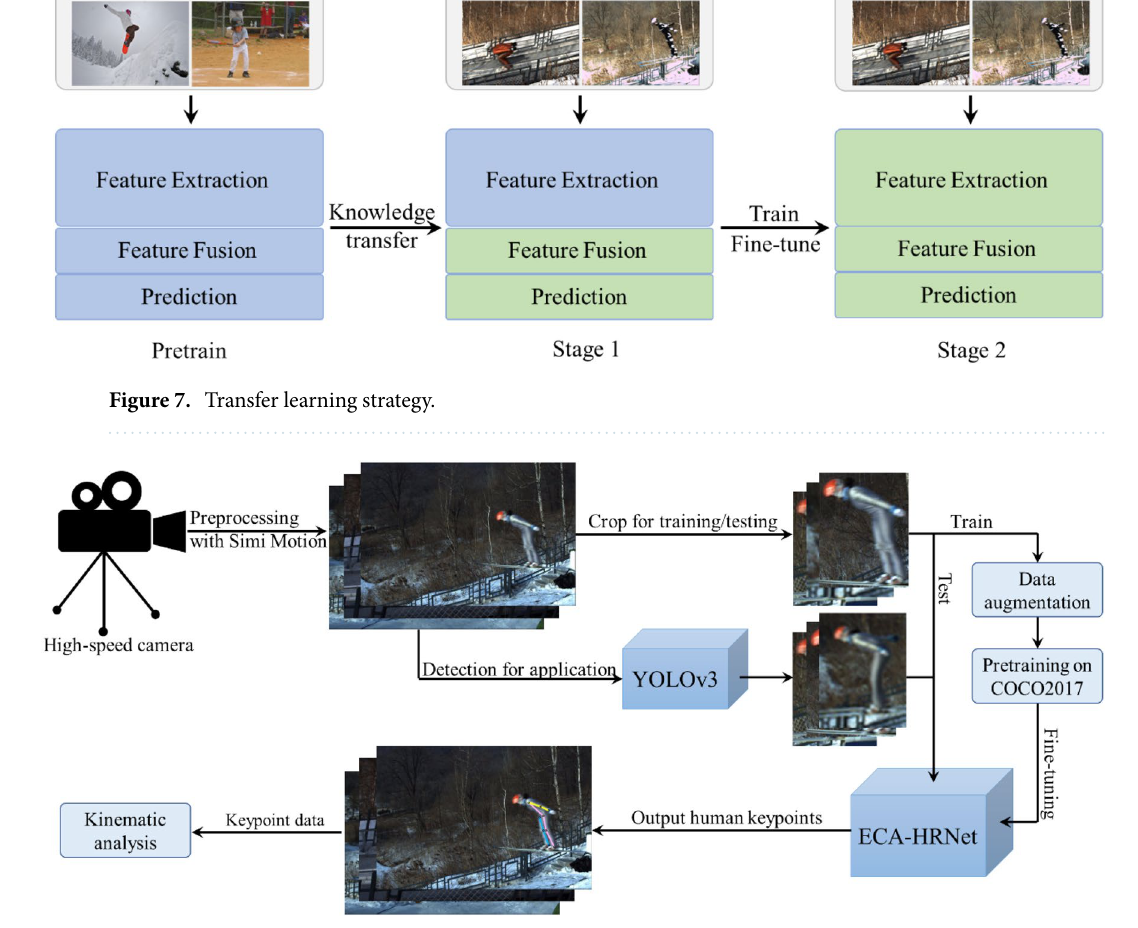
Figure 8. Schematic framework of the ski jumper pose